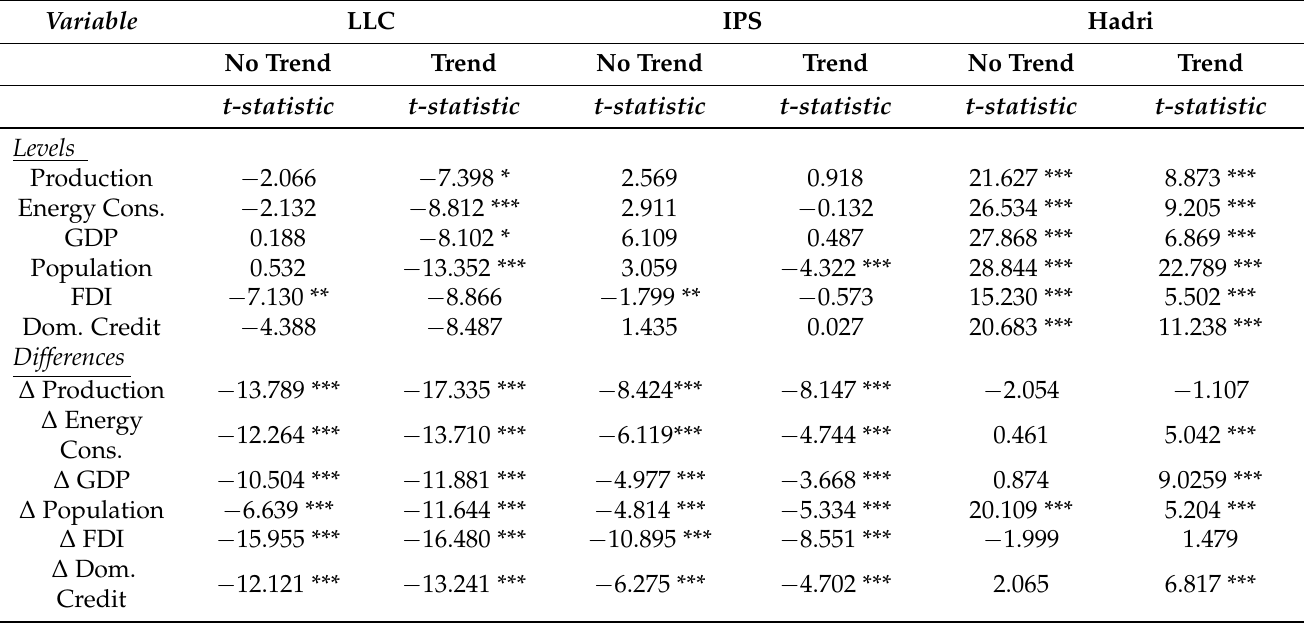
Table 2. Results of the panel unit root